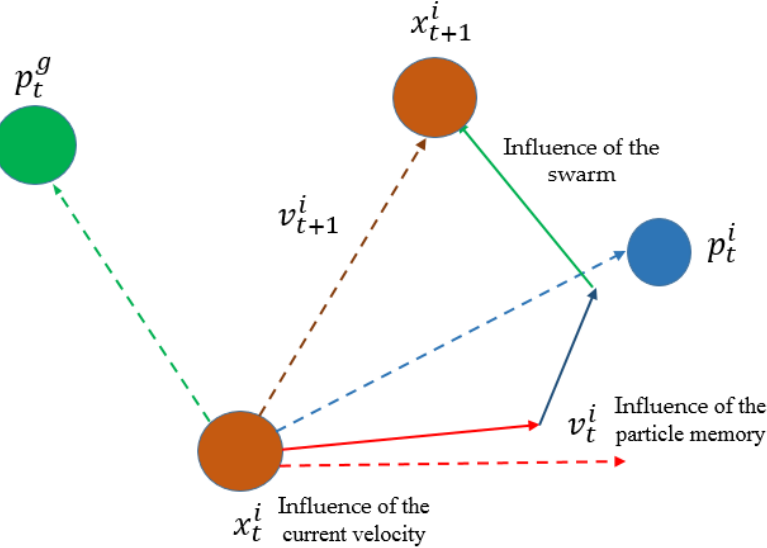
Figure 3. The iteration process of the particles.